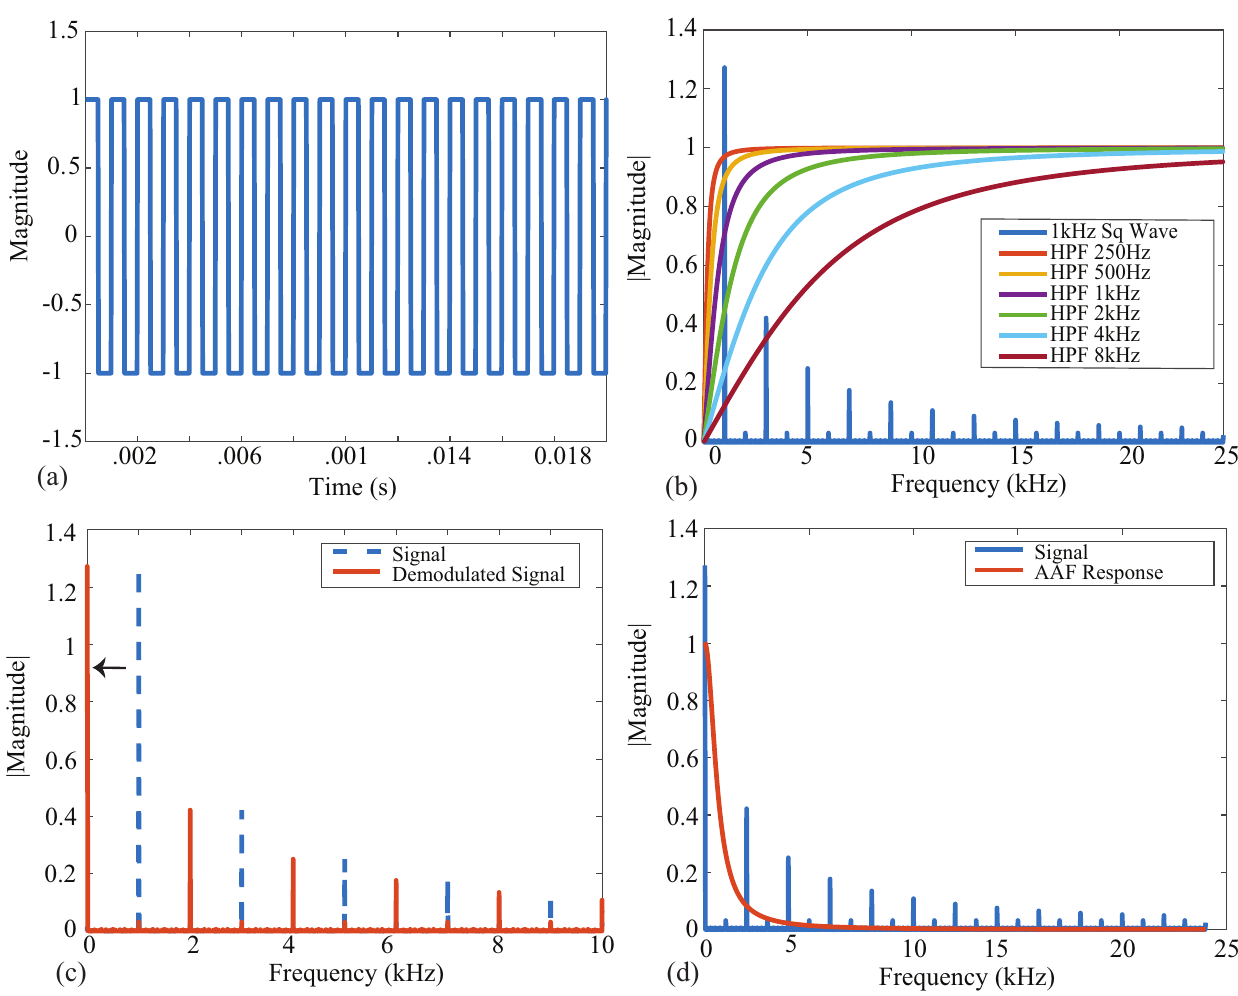
Figure 2. ( a ) Ideal square wave with an amplitude of 1 and a frequency of 1 kHz. ( b ) Single-sided frequency spectrum of a 1 kHz square wave (blue) plotted with ideal HPF magnitude responses with the corresponding cutoff frequencies. ( c ) Single-sided spectrum of a 1 kHz square wave (dashed blue) plotted with the demodulated (orange) signal. ( d ) Demodu- lated signal (blue) plotted with an AAF magnitude response